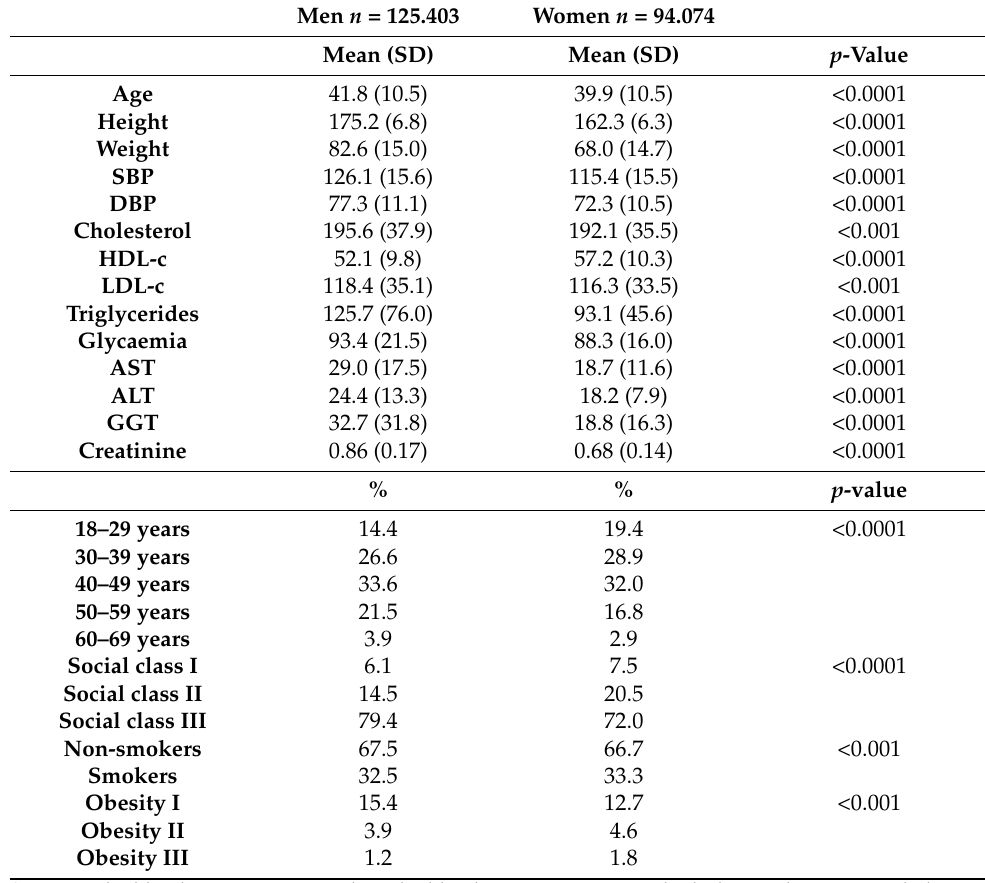
Table 1. Characteristics of the